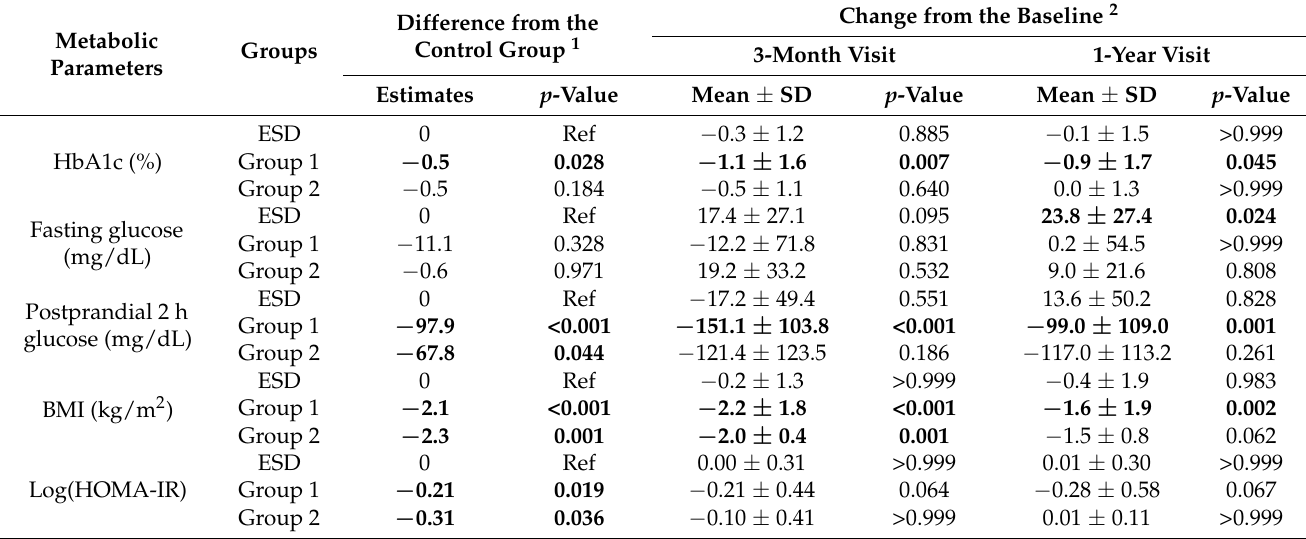
Table 3. Metabolic parameters during the 1-year follow-up